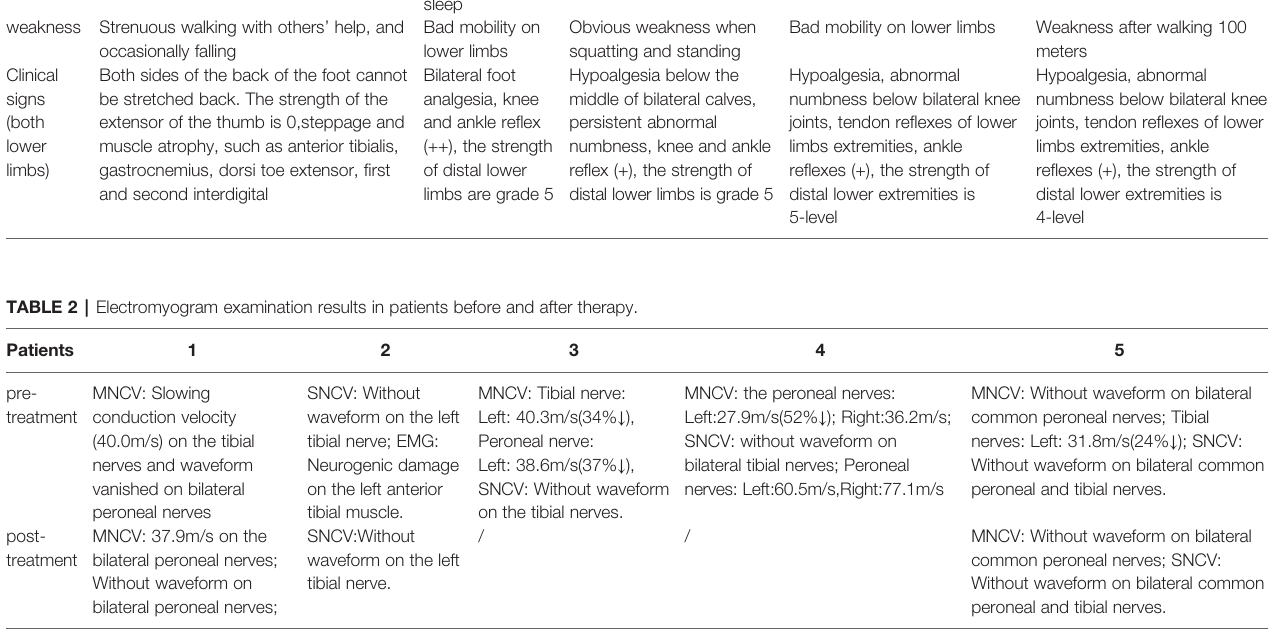
Occasional tingling below the middle of the calf